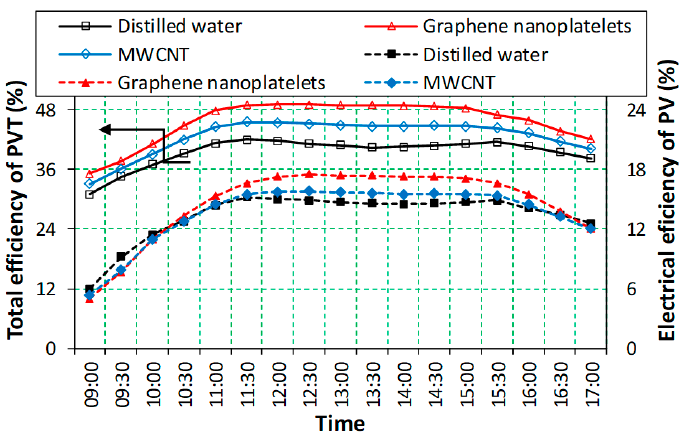
Figure 7. Changes in efficiency for the PV module and PV/T systems with different